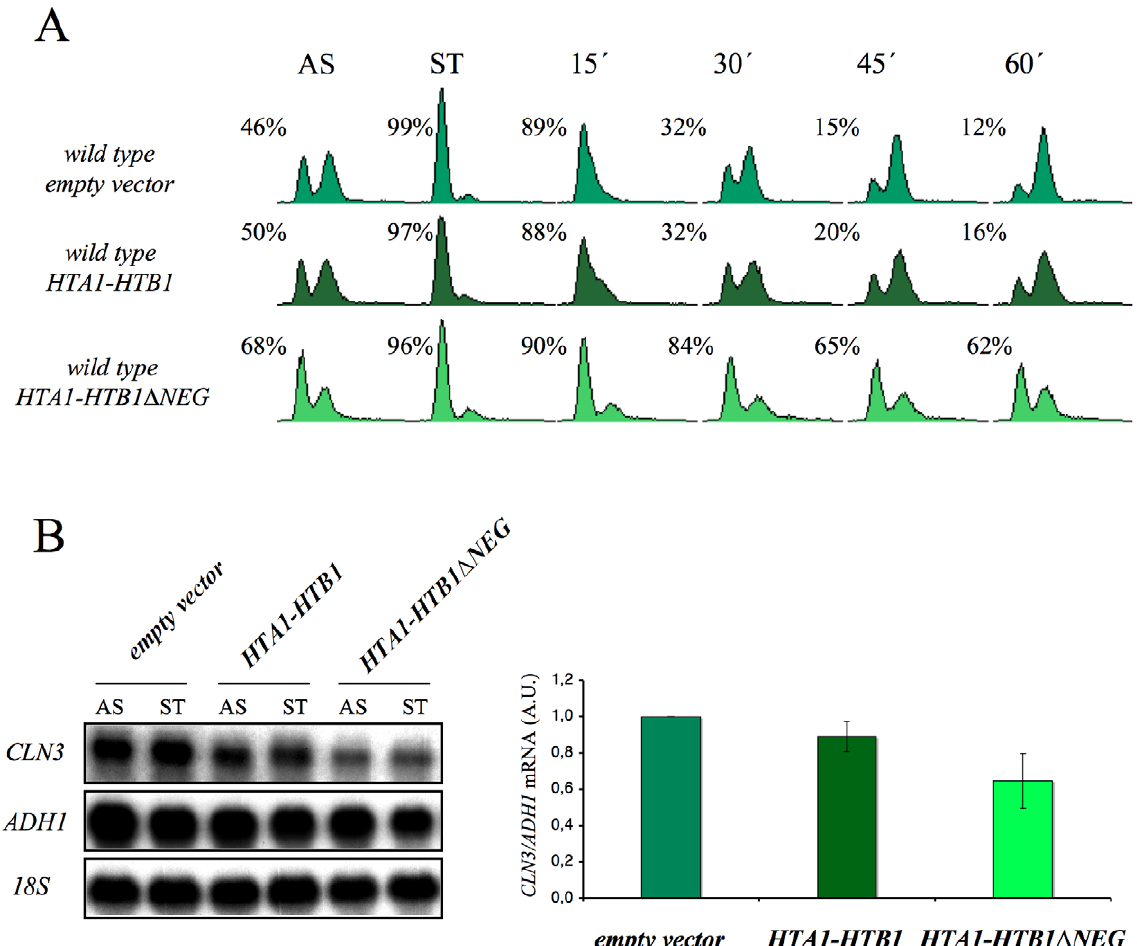
Figure 8. The overexpression of histones in the wild-type cells induces G1 delay. (A) Wild-type cells were transformed with pRS316 (empty vector) or with the analogous centromeric plasmids expressing either HTA1–HTB1 or a mutant version of this locus lacking the sequence that mediates its transcriptional repression in response to the free histones ( HTA1–HTB1 D NEG ). The transformants were grown exponentially in a selective medium (AS), synchronized at START by treatment with alpha-factor for two hours (ST) and released from the arrest by washing out the alpha-factor. Samples were then taken at the different time points to analyze the DNA content by flow cytometry and the proportion of unbudded cells by microscopy. (B) Aliquots from the synchronized cells used in (A) were taken to analyze the CLN3 mRNA levels in START by Northern blot. The results of a typical experiment and the average quantification of three independent experiments are shown. The CLN3 mRNA levels have been normalized to ADH1